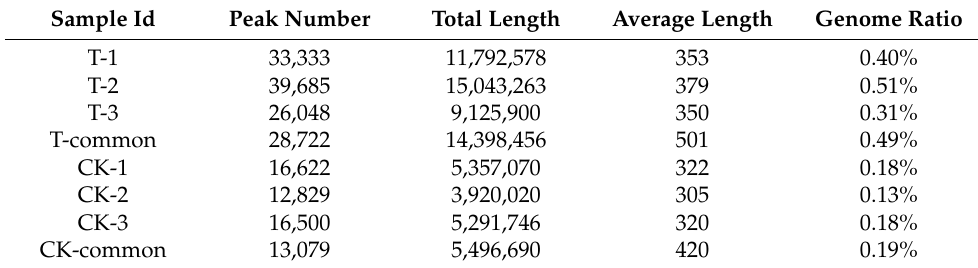
Table 2. Statistical table for the peak of each